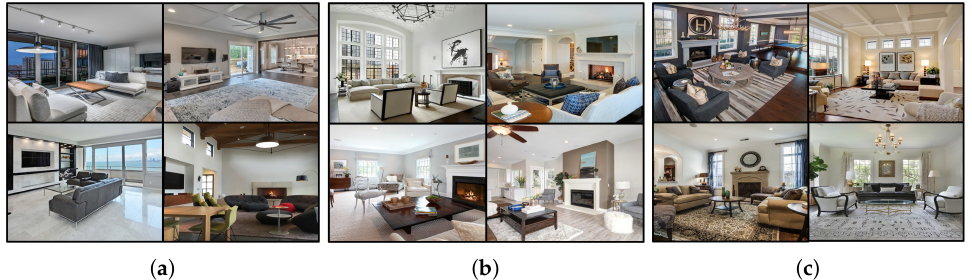
Figure 9. Examples of images estimated as modern. ( a ) Image labeled as modern style. ( b ) Image labeled as traditional for ResNet. ( c ) Image labeled as traditional for the proposed method.